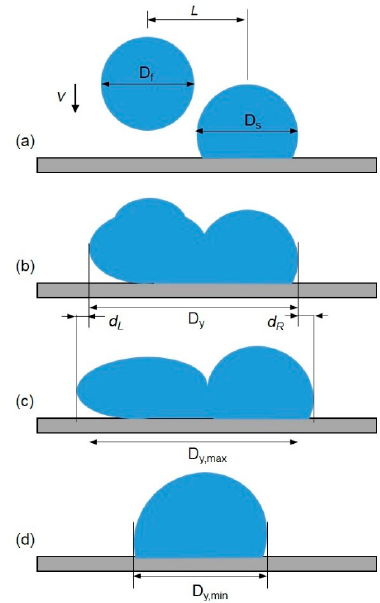
Figure 12. Sketch of ( a ) the deposition of two droplets on a solid surface; D f is the diameter of the falling droplet; D s is the diameter of the sessile droplet; and L is the center-to-center distance; ( b ) Spread length D y ; ( c ) maximum spread length D y,max ; ( d ) minimum spread length D y,min .